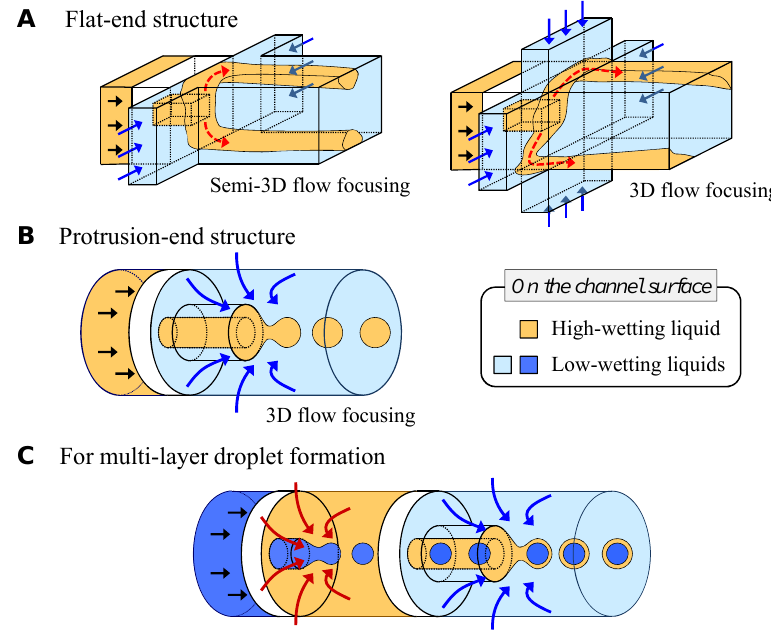
Figure 1. Principle of droplet formation for highly wettable liquid using protrusion channel and three-dimensional focusing.